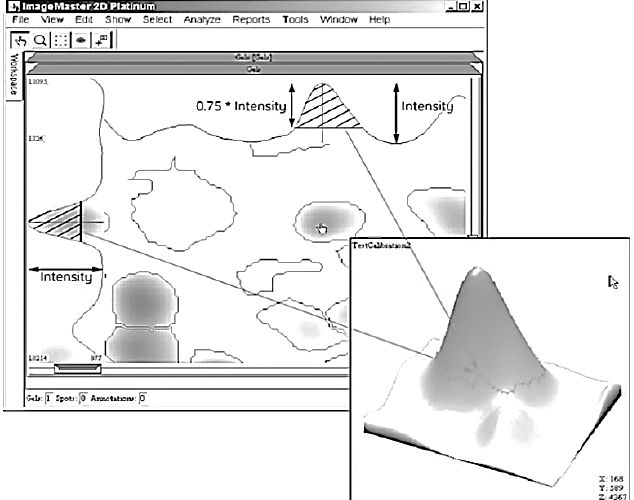
Fig. 4. 3D model construction algorithm of study image area. Arrows indicate a difference in calculation of intensity, area, and volume parameters